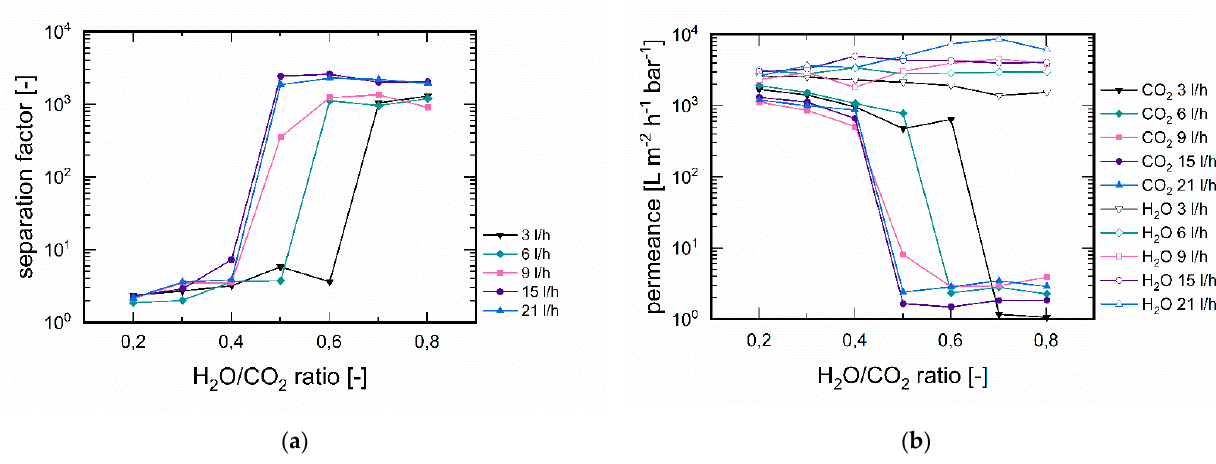
Figure 8. Influence of feed flux on ( a ) separation factors and ( b ) H 2 O and CO 2 permeances. The sweep flow was adjusted to the feed flow and is the same in each case (T = 90 °C, p feed = 1.9 bar, p permeate = 1.0 bar).